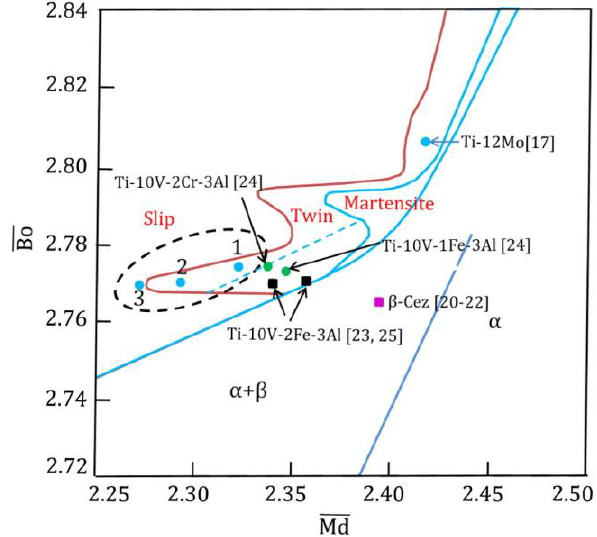
Figure 17. The proposed modified phase stability diagram for metastable and near-beta Ti alloys